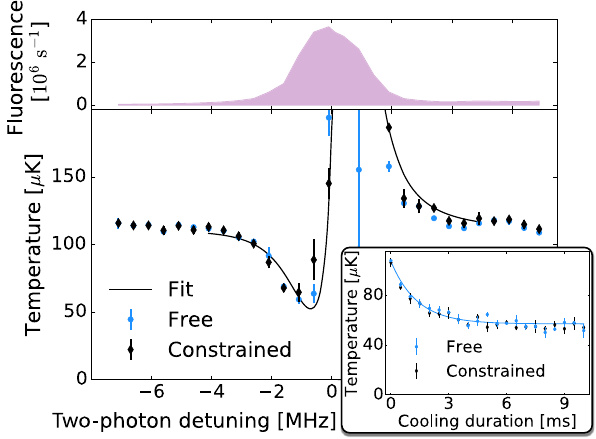
FIG. 3. Detuning dependence of 420-nm fluorescence (top) and the resulting temperature (bottom) of rubidium atoms laser cooled by an optical frequency comb on a two-photon transition. The solid curve is fit for scattering rate, effective linewidth, and detuning offset of data analyzed with the aid of a Monte Carlo technique (data labeled “ Constrained ” ; see Ref. [25]). The same data are also analyzed using a free-expansion model ( “ Free ” ), and agree well with the Monte Carlo assisted analysis. Inset: Temperature versus time when the laser detuning is optimized for cooling, giving a minimum temperature of ð 57 (cid:3) 2 Þ μ K. The time decay of the 420-nm fluorescence shows that atoms leave the interaction region due to transverse motion in ð 4 . 0 (cid:3) 0 . 3 Þ ms, but steady-state 1D temperature is reached in τ ¼ ð 1 . 28 (cid:3) 0 . 09 Þ ms. Error bars are statistical over repeated measurements, and do not include the systematic effect of beam mode mismatch, discussed in text.